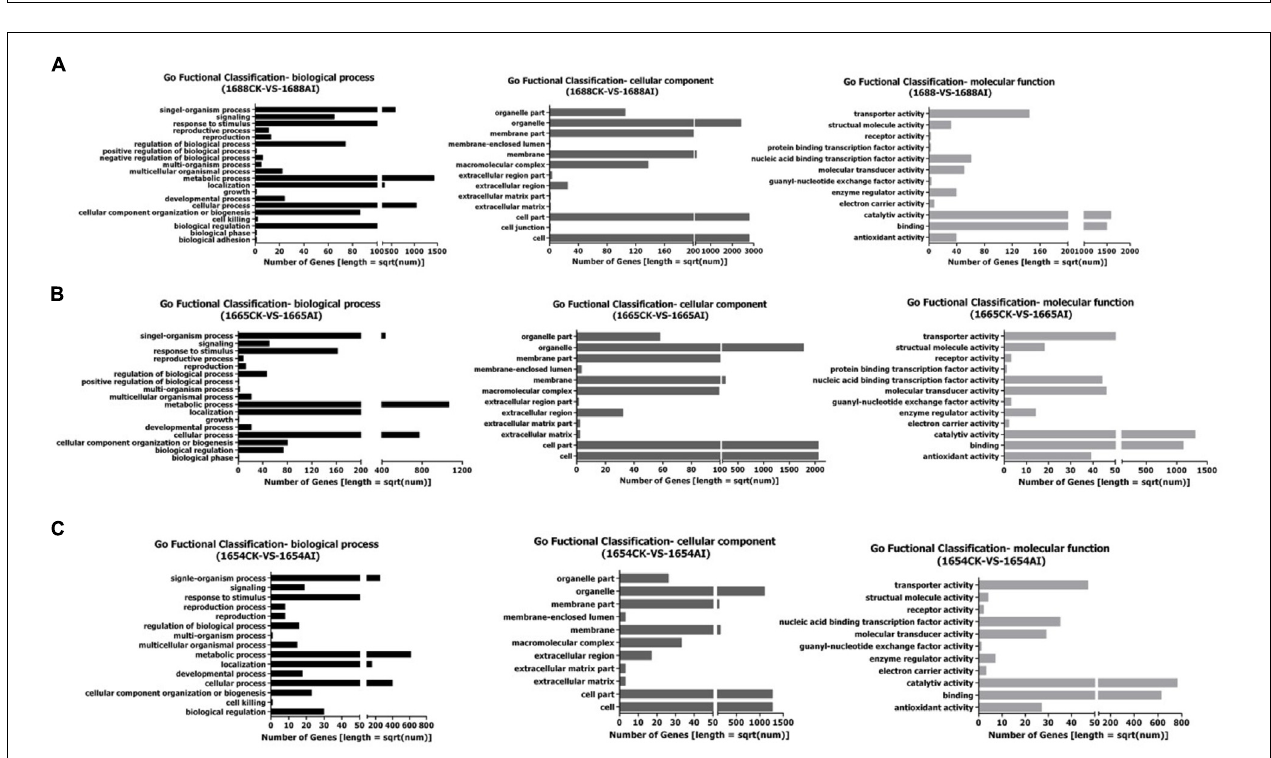
FIGURE 2 | Gene Ontology (GO) Functional Classification: (A) 1688CK-vs-1688AI; (B) 1665CK-vs-1665AI; (C) 1654CK-vs-1654AI.